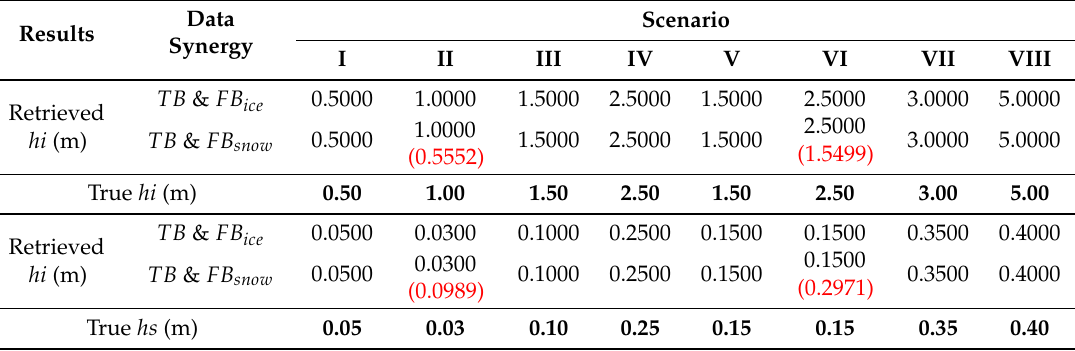
Table 2. Retrieved sea ice parameters ( hi and hs ) for typical scenarios in Table 1. For the case with two potential solutions, the bold texts show the true solution, while the red texts in parentheses the other potential solution. The case with double solutions is only possible for the synergy of TB and FB snow